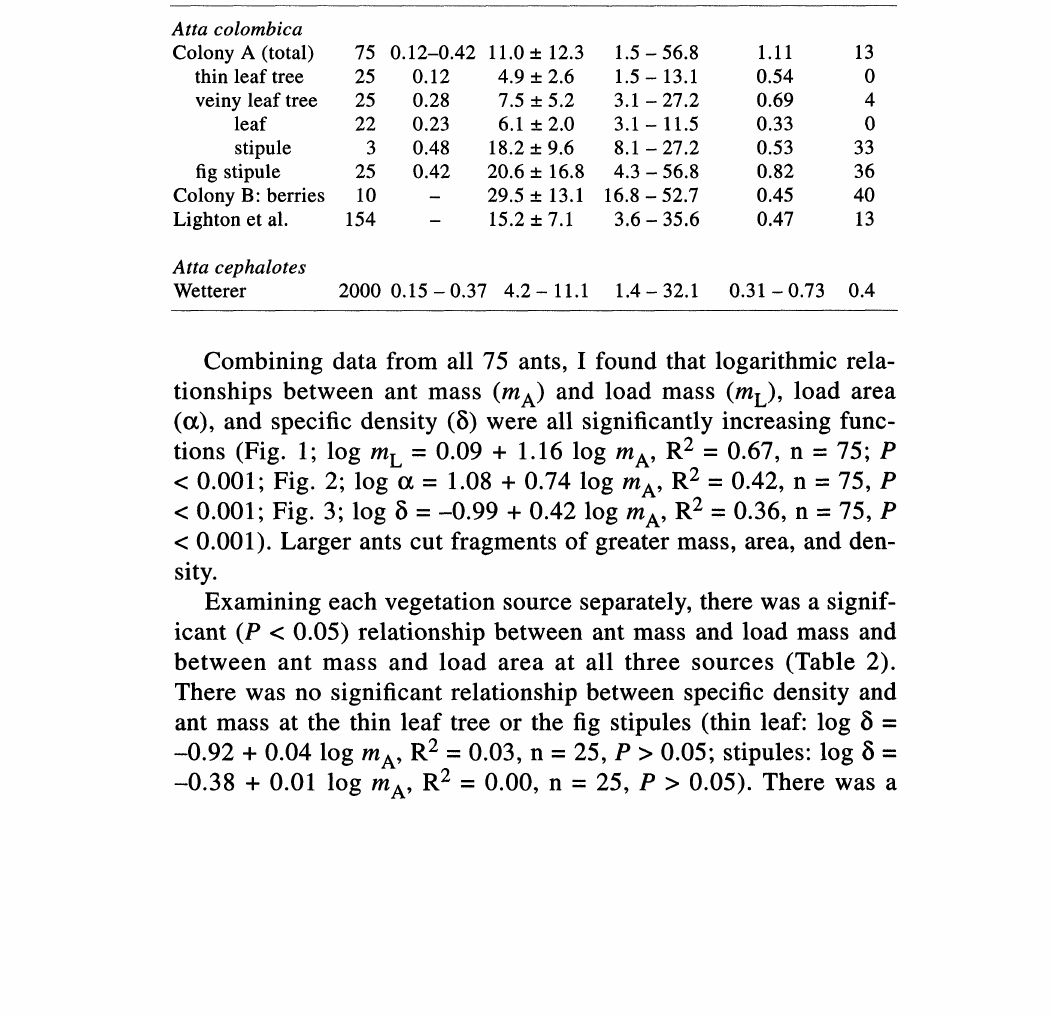
Table 1. Atta colombica forager mass at different sources compared with data from earlier studies with Atta cephalotes. A. colombica: foragers from one colony (colony A) collected coming from three different vegetation sources (thin leaf tree, veiny leaf tree, and fallen fig stipules), from a second colony (colony B) carrying whole berries, and data from Lighton et al. (1987). The data from the veiny leaf tree are further divided into data for ants with leaf fragments and for ants with leaf stip- ule fragments. Overall specific density (D